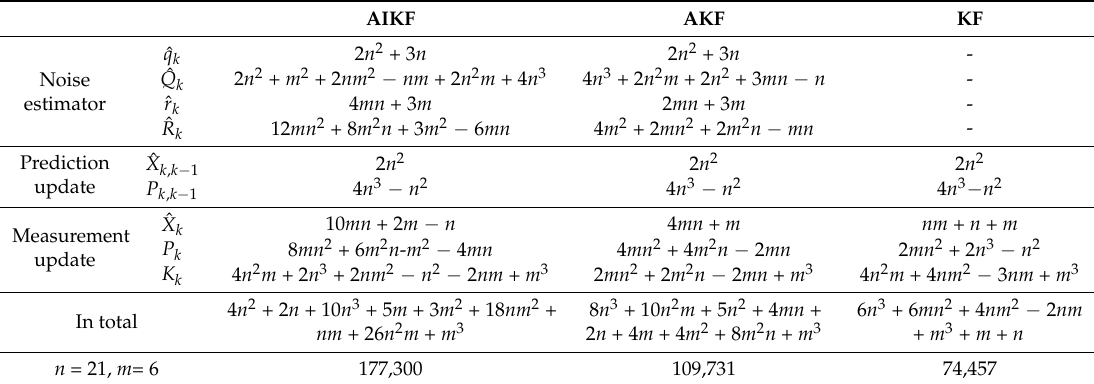
Table 1. Calculation amount of each